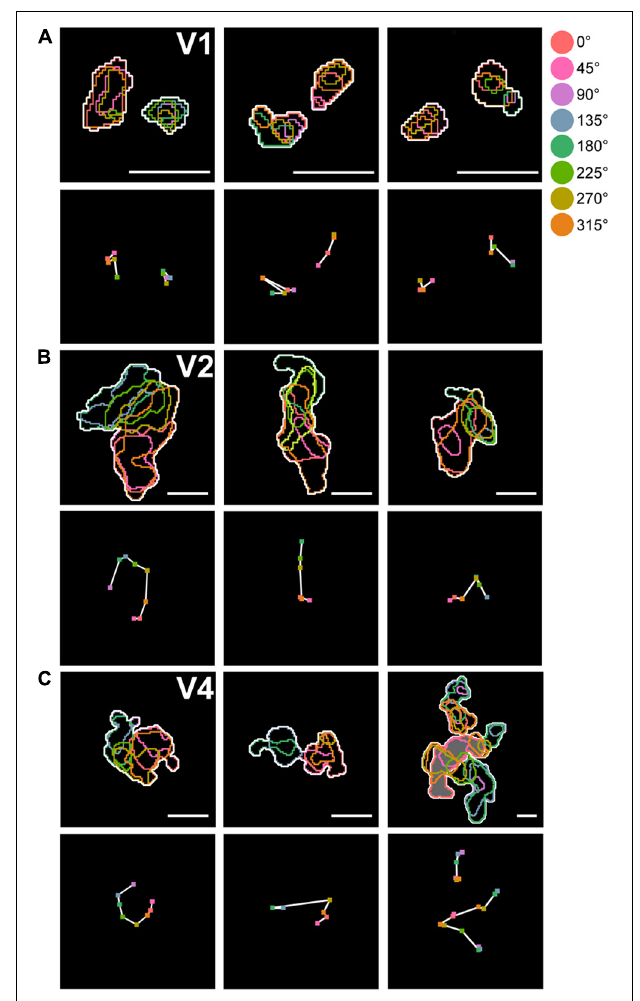
FIGURE 6 | Arrangement of domains within hue clusters. (A) Top row: examples of arrangement of hue domains within hue clusters in V1. Color contours indicate hue domains, and white contours indicate hue clusters. Bottom row: Response peak points within individual hue domains are marked with colored dots. The peaks of adjacent domains in the hue angle are connected by white lines, showing their arrangement along the hue angle. (B,C) Same conventions as in (A) , but in V2 (B) and in V4 (C) . The upper right panel in (C) contains three clusters, with the uppermost cluster adjacent to another cluster. The lower two clusters merged and shared some hue domains (shown with gray background). Scale bar, 250 µ